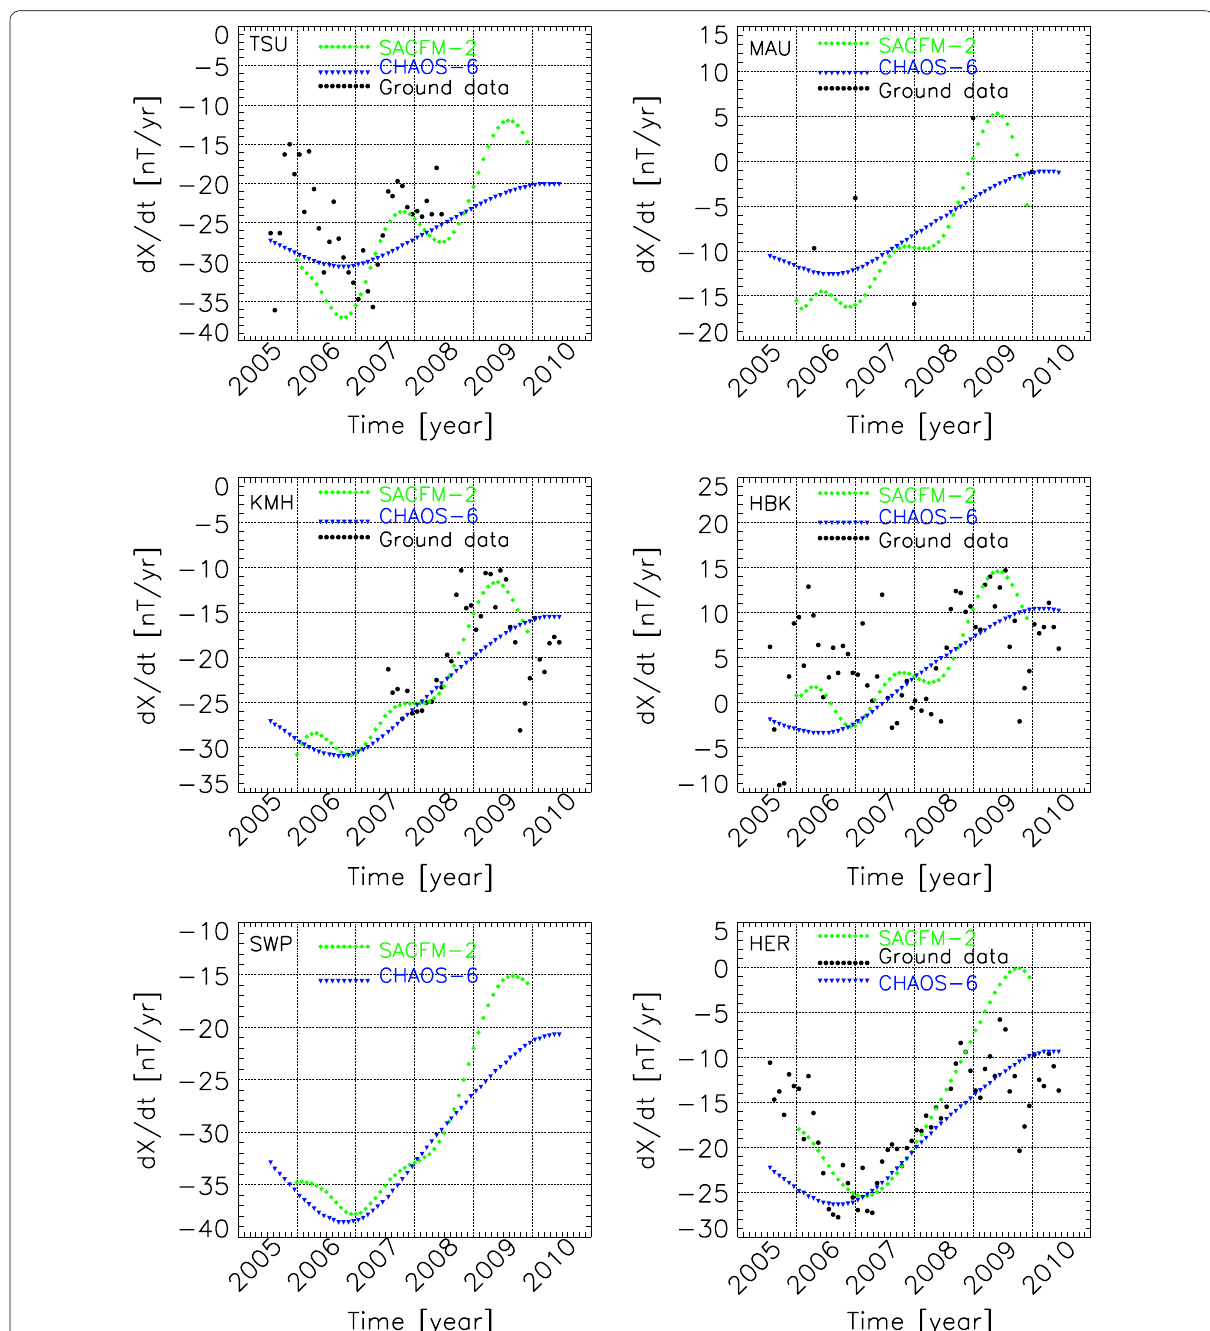
Fig. 5 Secular variation at TSU, KMH, MAU, SWP and HER for X component. Secular variation of the X component at the four observatories (data in black) and two additional reference points between 2005 and 2010 as given by SACFM-2 (green) and CHAOS-6 (blue)